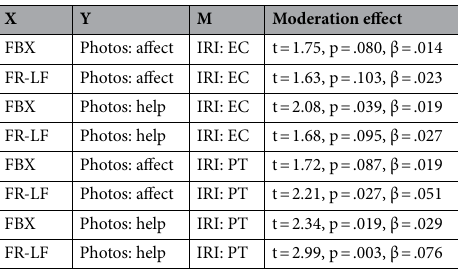
Table 5. Moderation analyses in the out-group condition. FBX fear-based xenophobia, FR-LF right wing extremist attitudes, IRI interpersonal reactivity index, PT perspective taking, EC empathic concern.